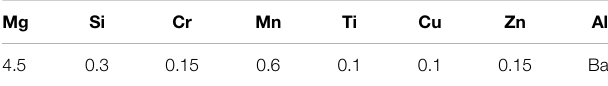
TABLE 1 | The chemical component (wt%) of 5,083 aluminum alloy.